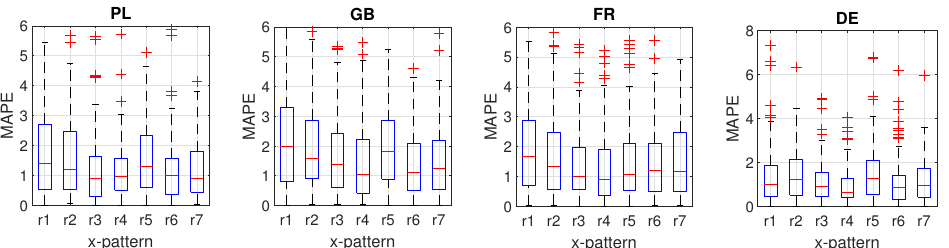
Figure 6. Global extended training mode: Boxplots of validation MAPE for different input patterns